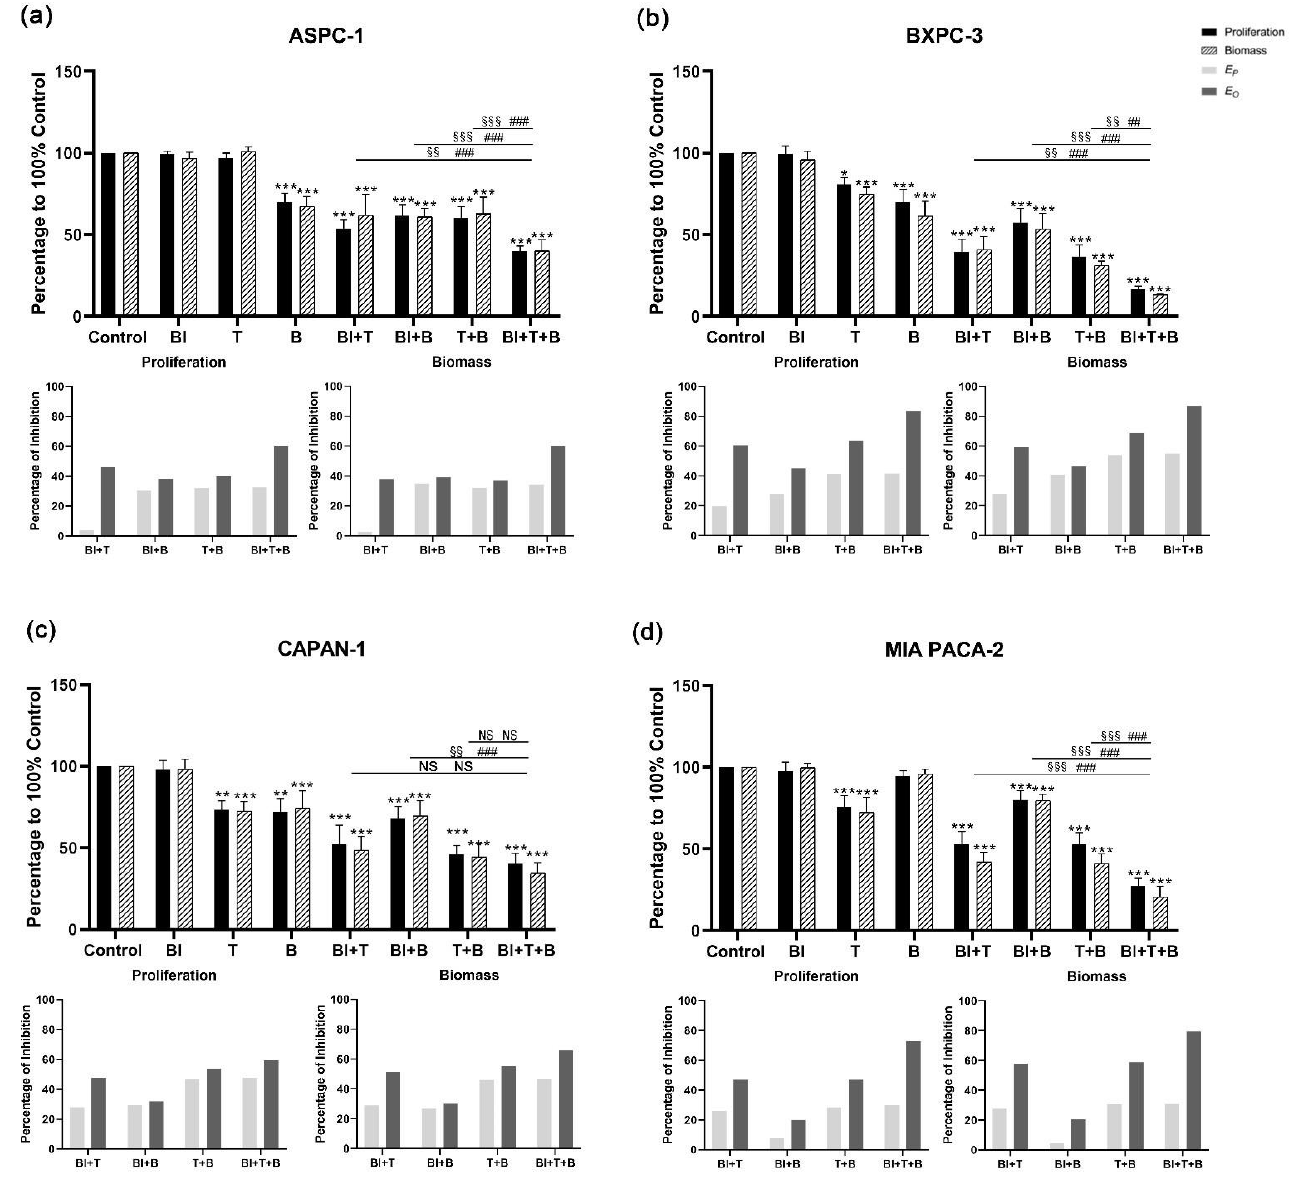
Figure 3. Cell proliferation and biomass of ASPC-1 ( a ), BXPC-3 ( b ), CAPAN-1 ( c ), and MIA PACA-2 ( d ) after 72 h BI-3406, trametinib, buparlisib or inhibitor combination exposure, as well as analysis of synergistic effect using Bliss independent model. Data are presented as mean ± SD. Significance of a treatment effect compared to the DMSO control was determined by one-way ANOVA and displayed as *: p < 0.033, **: p < 0.002, ***: p < 0.001 ( n ≥ 3). The significance of the treatment effect for double inhibition compared to triple inhibition was determined by one-way ANOVA and was shown as # (proliferation), § (biomass): p < 0.033; ##, §§: p < 0.002, ###; §§§: p < 0.001. BI: BI-3406; T: trametinib; B: buparlisib; NS: not significant; E P : predicted inhibition by Bliss independent model; E O : observed